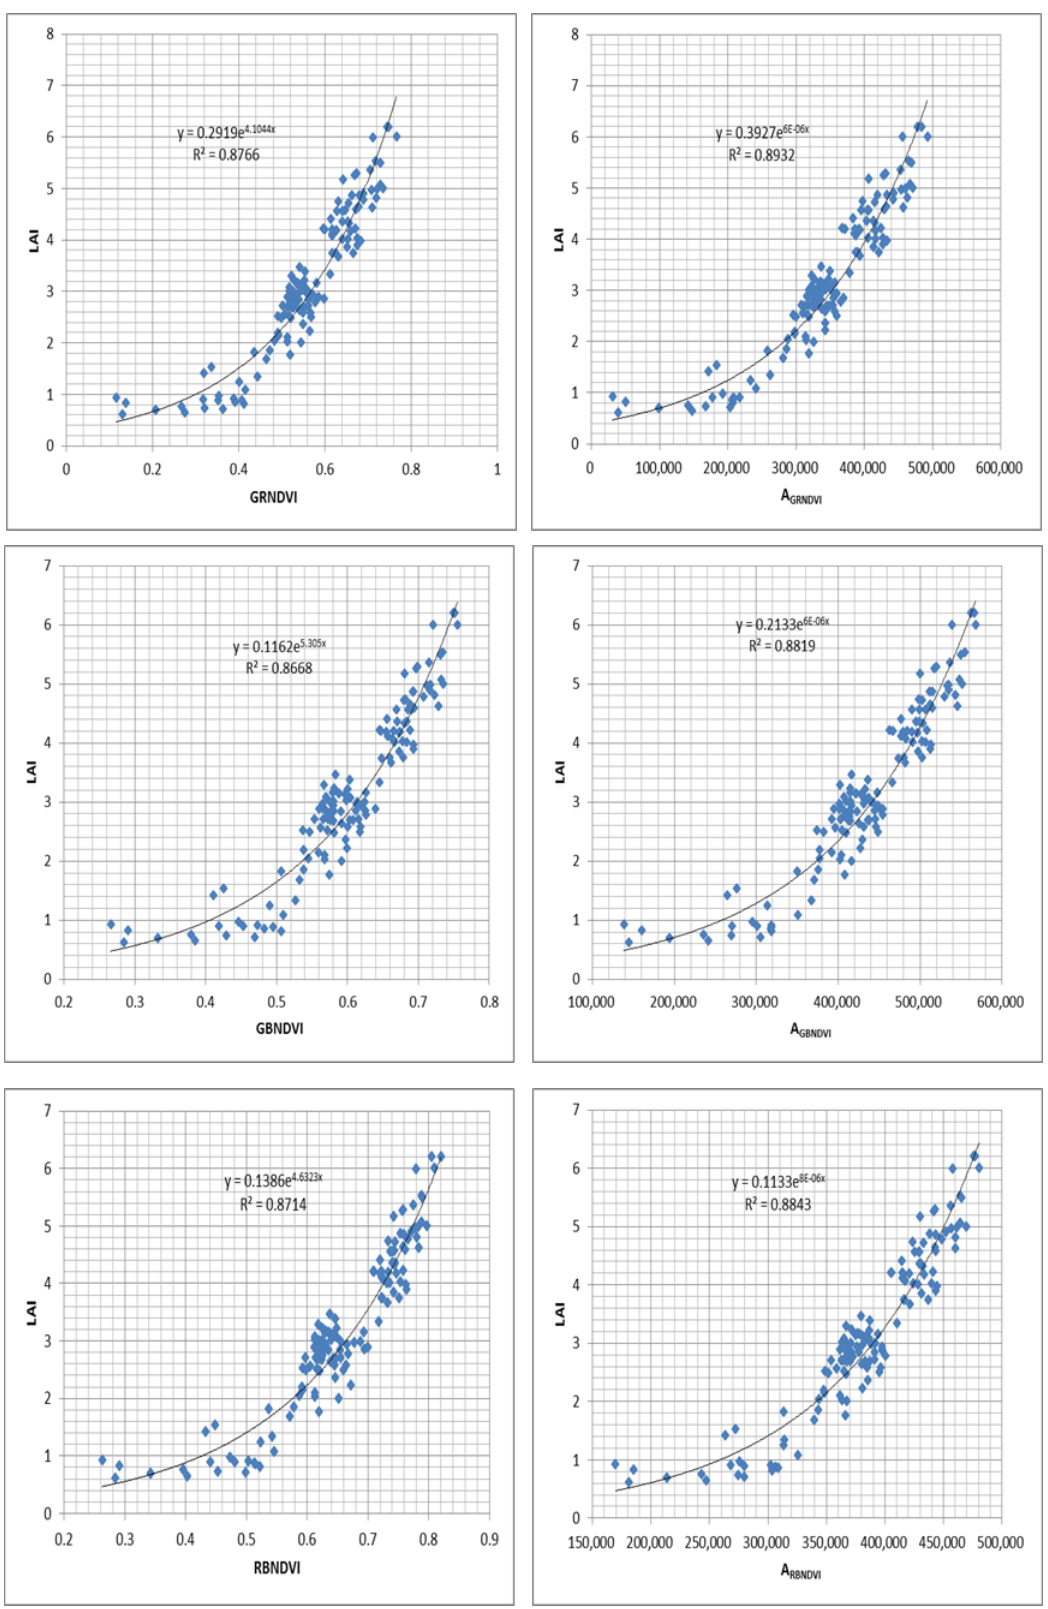
Figure 2. Inversion models between NDVI, its derivative parameters, and rapeseed LAI. Note: significant level is 1% (n = 150).